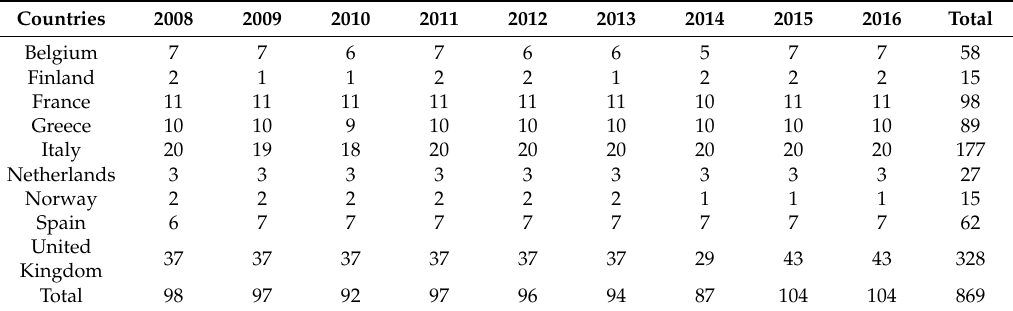
Table 1. Observations distribution per country and